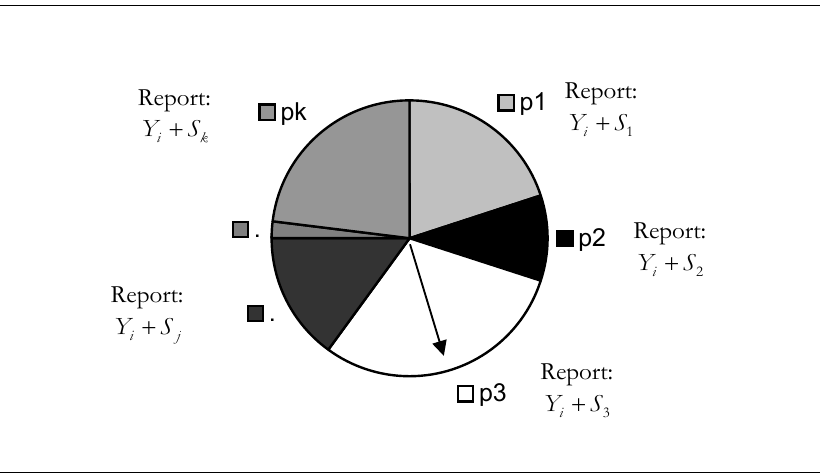
Figure 1 – Spinner for